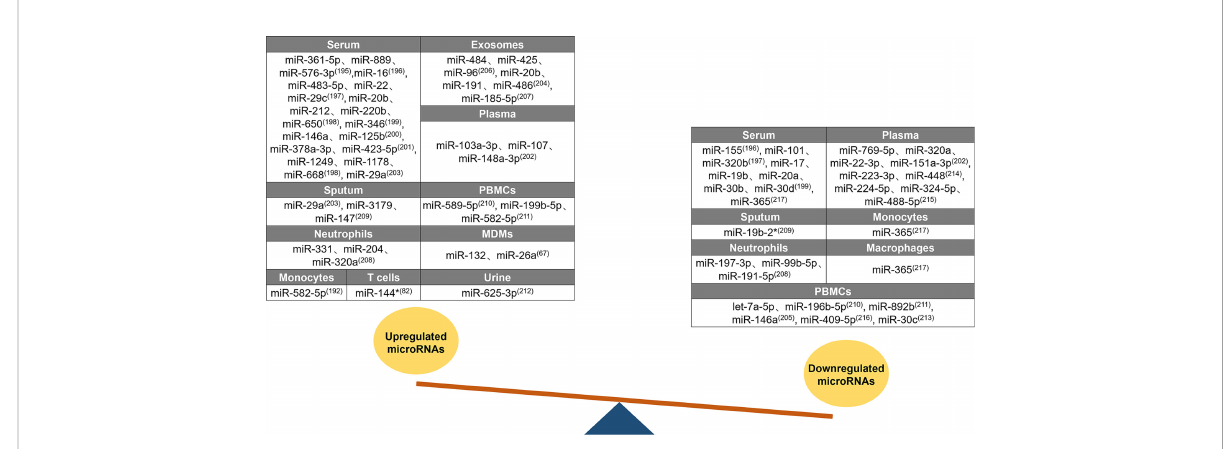
FIGURE 3 Differential expression of miRNAs after Mtb infection. Differential expression of miRNAs between tuberculosis patients and healthy individuals. Forty-three upregulated miRNAs are counted in serum, exosomes, plasma, sputum, PBMCs, neutrophils, MDMs, monocytes, T cells, and urine. Twenty-eight downregulated miRNAs are counted in serum, plasma, sputum, monocytes, neutrophils, macrophages, and PBMCs. Similar expression pro fi les of miRNAs (miR-29, miR-582-5p, miR-20b, miR-320, miR-19b, miR-30, and miR-365) are counted in multiple samples, while fi ve miRNAs (miR-22, miR-20, miR-146a, miR-191, and miR-320) are with distinctive expression trends in different